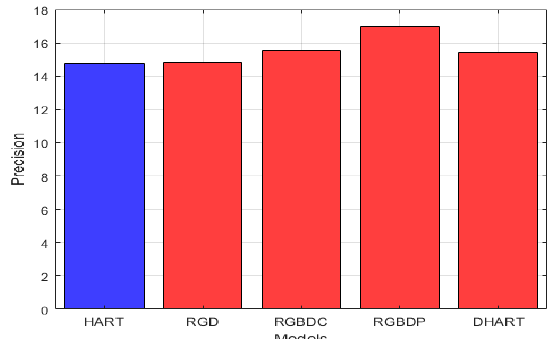
Figure 7. The comparison of mean average precision between HART and our four different approaches. The best approach is the RGBD-parallel model, which demonstrated an improvement of 15% over the original mean average precision of the HART model.